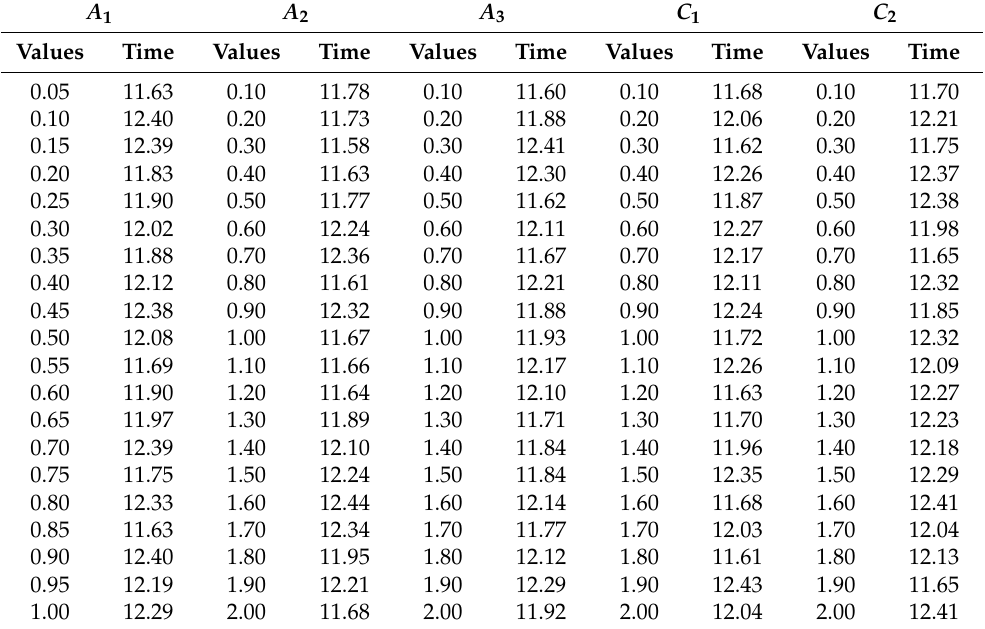
Table 14. Convergence time results (in seconds) for different values of ADSCFGWO’s parameters (2).